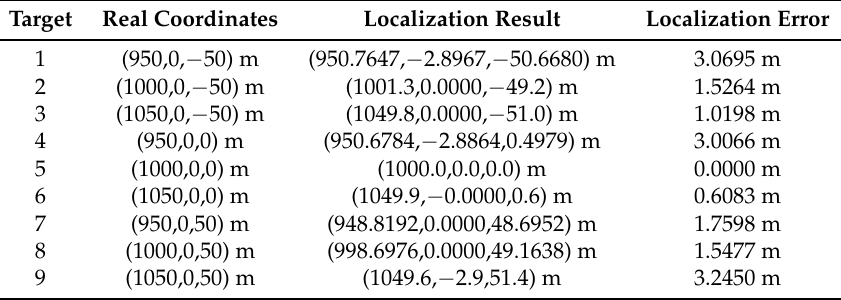
Table 6. Velocity error simulation results.